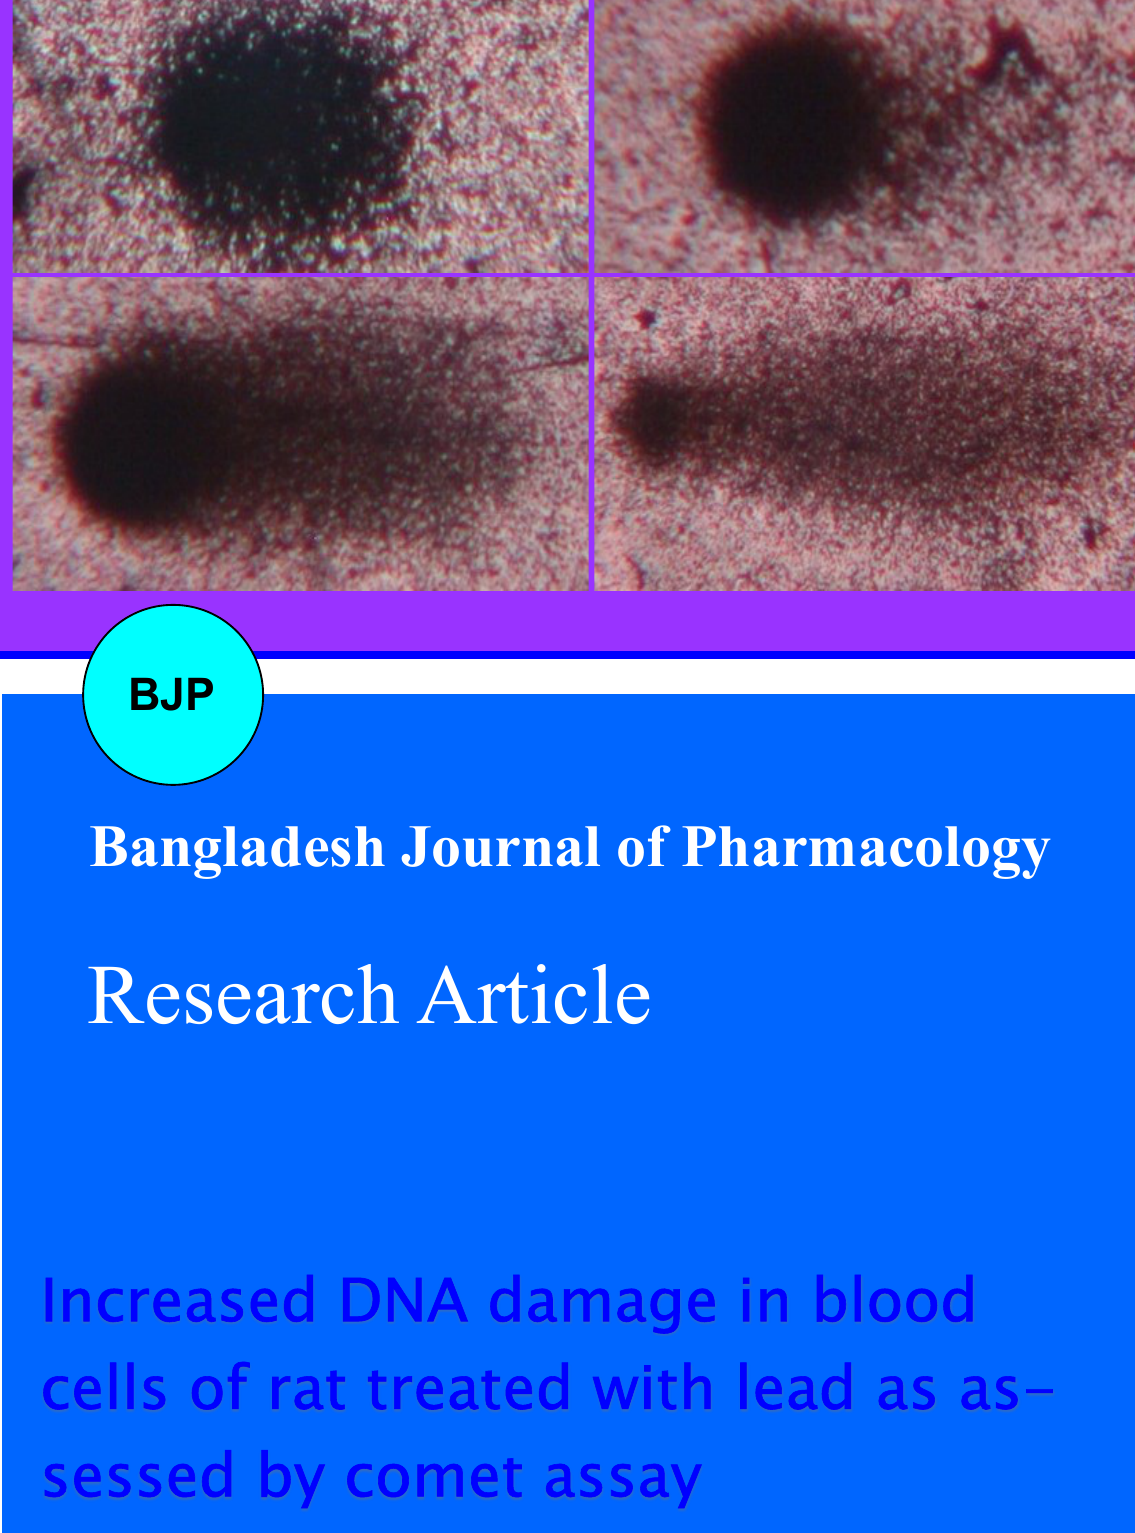
Increased DNA damage in blood cells of rat treated with lead as as- sessed by comet